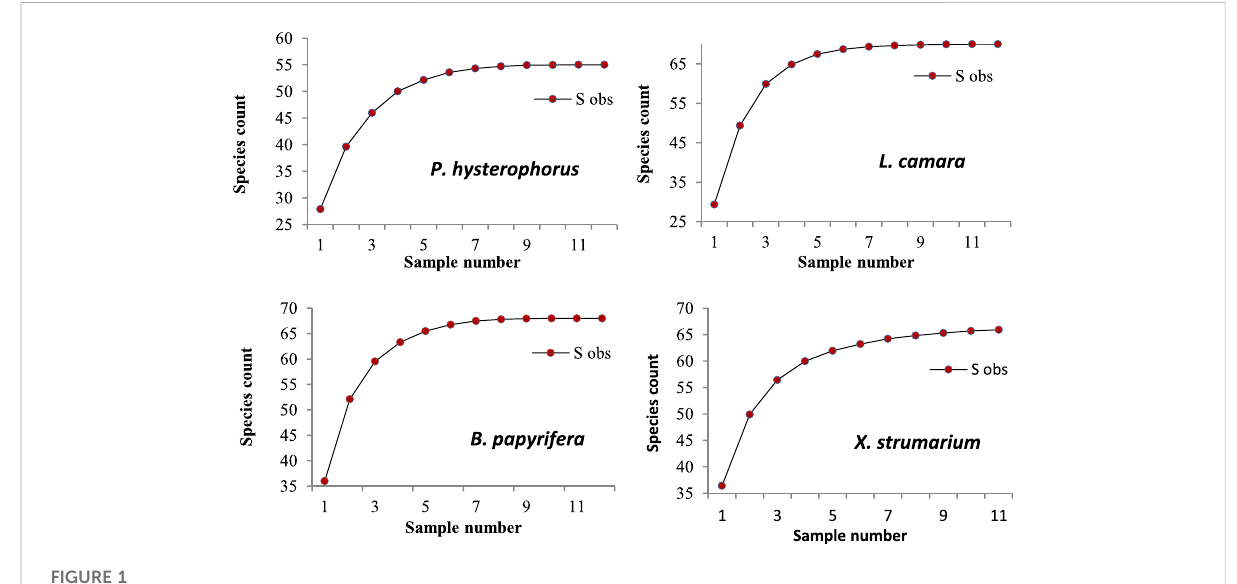
A rarefaction curve illustrates the total number of species observed.